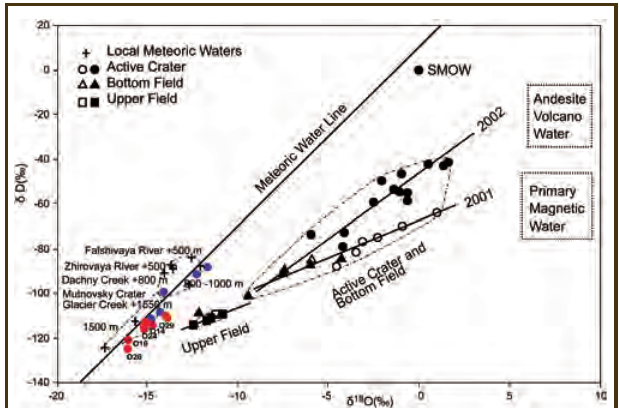
Figure 5. Integrated δ D vs δ 18 O data of the Mutnovsky geothermal field (red circles - production wells, blue circles - meteoric waters; Kiryukhin et al., 1998; 2002) and Mutnovsky crater fumaroles (Zelensky et al.,